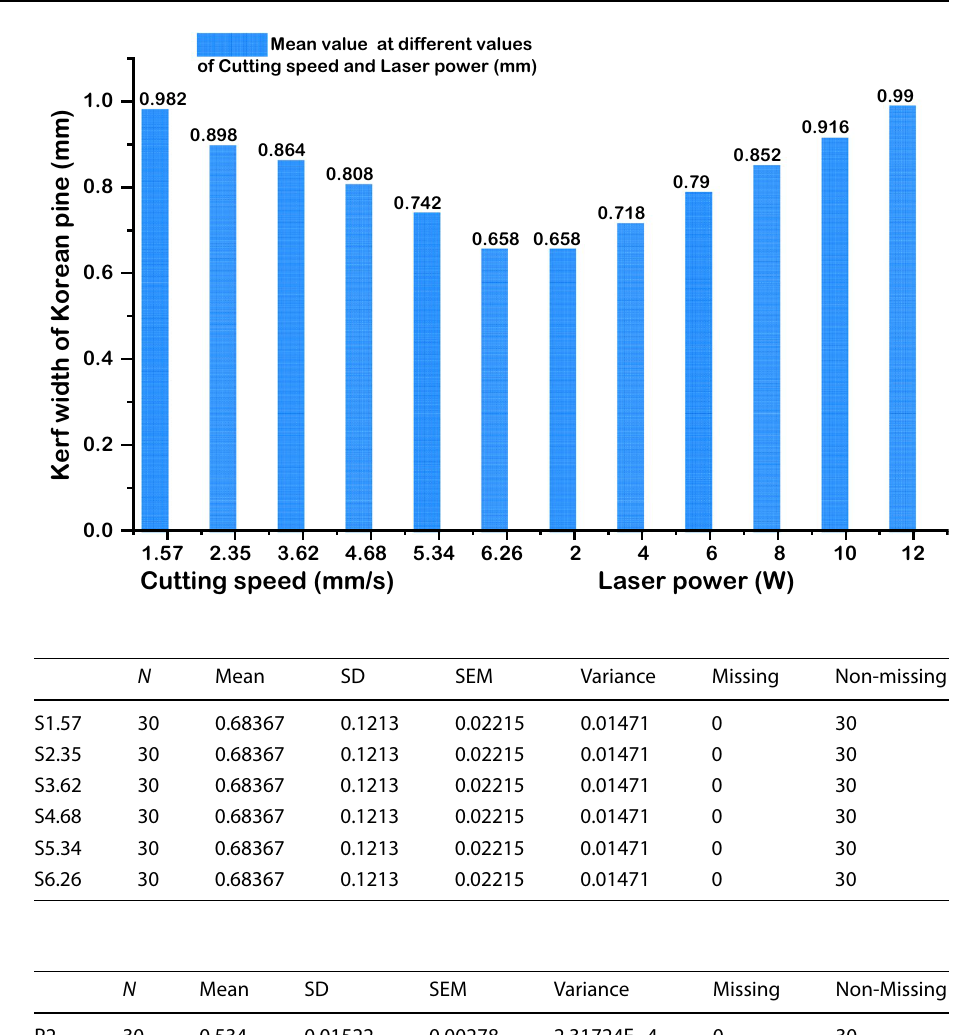
Fig. 18 Illustration of Korean pine kerf width under M M 2